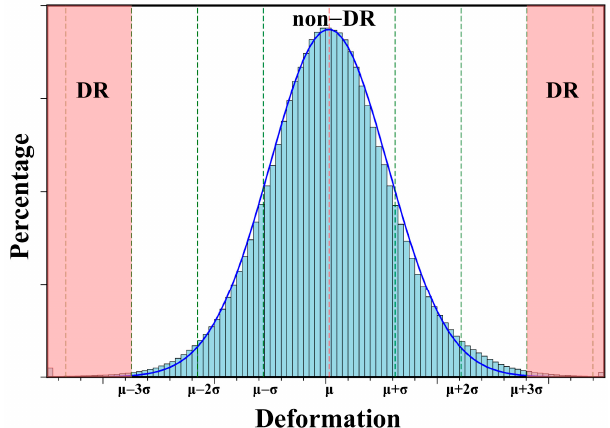
Figure 2. Distribution histogram of deformation results and its fitting normal distribution curve. The red dashed line represents the mean value of the deformation result, the green dashed line represents the standard deviation, and the light-red boxes represent the landslide deformation regions.